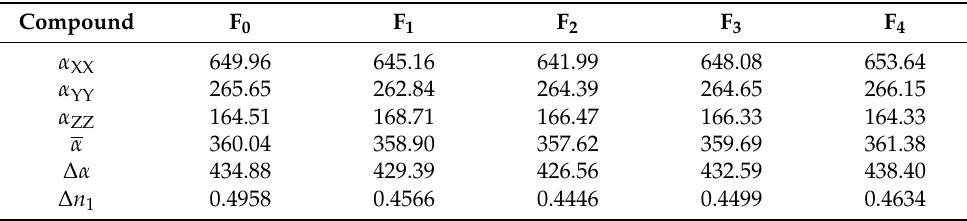
Table 3. The DFT calculated isotropic component α = ( α XX + α YY + α ZZ )/3, anisotropy ∆ α = [ α XX −